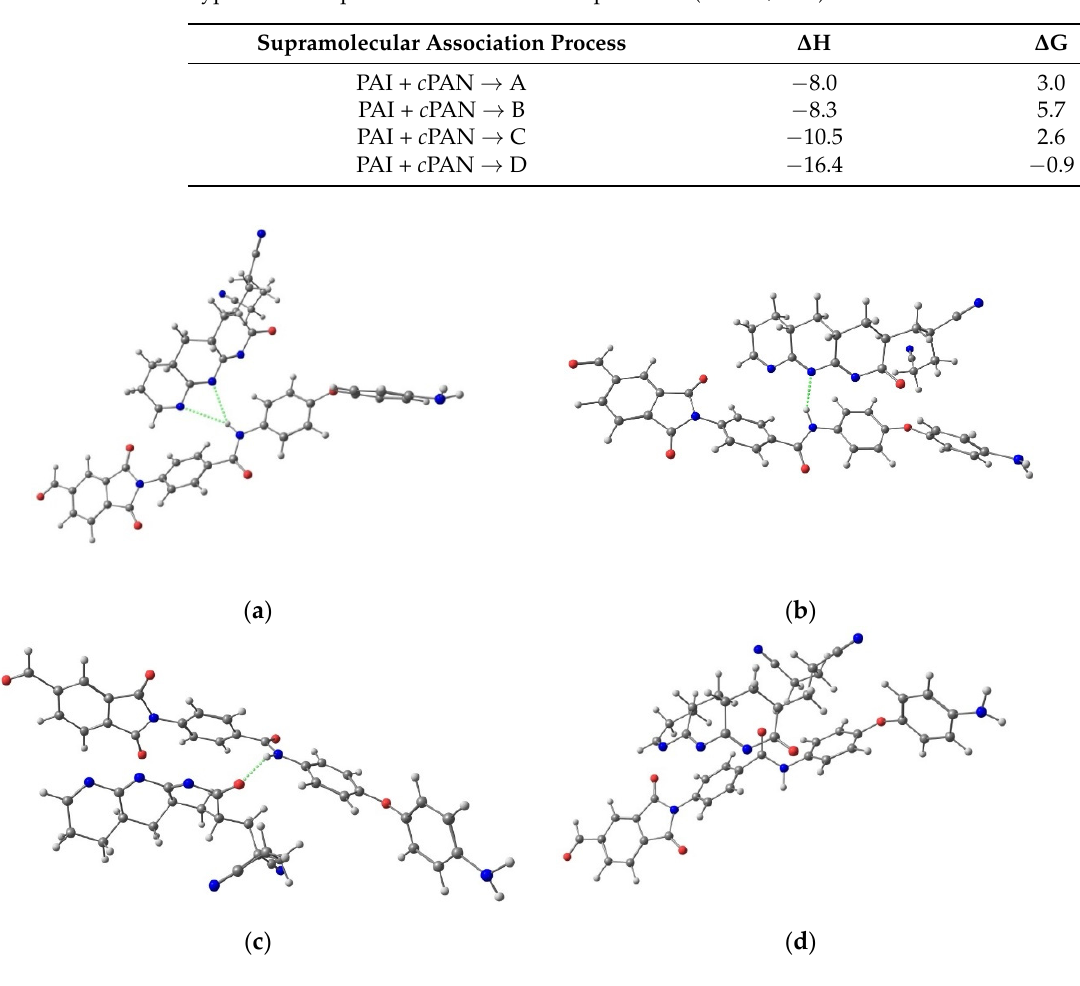
Table 3. Calculated values of enthalpies and Gibbs free energies of reaction ( ∆ H and ∆ G) for various hypothetical supramolecular association processes (in kcal/mol).